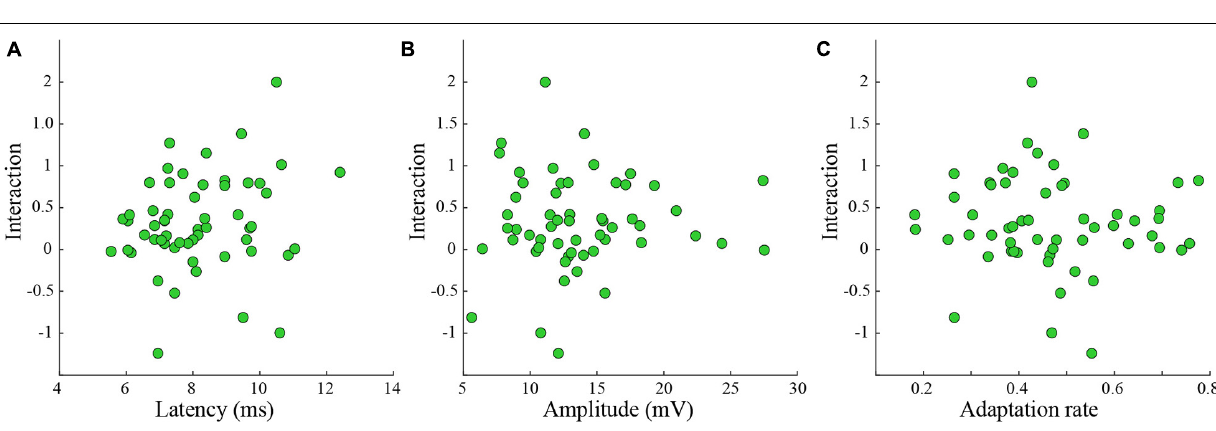
FIGURE 3 | Interacting and non-interacting whisker-inputs have similar response parameters. (A) The averaged response amplitudes during 5 Hz stimulation of interacting (purple) and non-interacting whisker-inputs (green). (B) The averaged rise time of the interacting and non-interacting whisker-inputs was increased as stimulation progressed, it was significantly different only during the 6th stimulation. (C) The average latencies of interacting and non-interacting whisker-inputs were not significantly different. Error bars represent SEM in all panels.